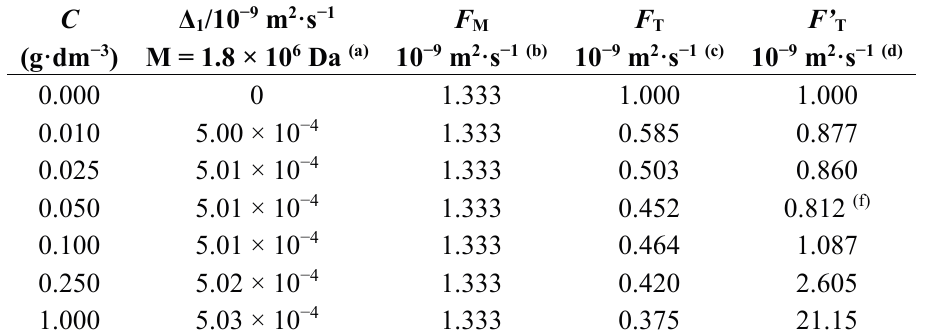
Table 4. Mobility factor, F M , and thermodynamic factor, F T , of NaHy alculated from our experimental D values and from Equations (3) to (7) at T = 25 °C and at atmospheric